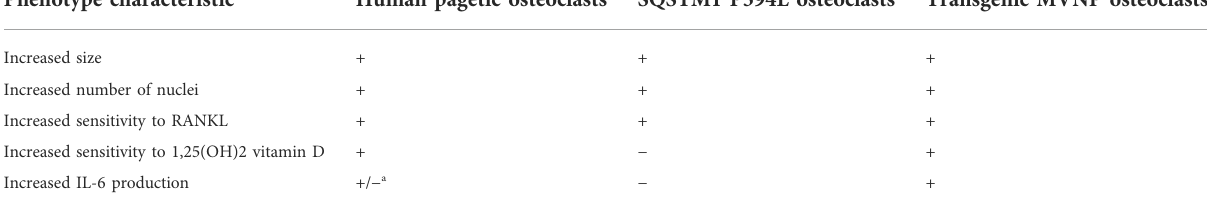
TABLE 3 Major in vitro characteristics of pagetic osteoclasts from PDB patients, SQSTM1 P394L mice or transgenic MVNP mice